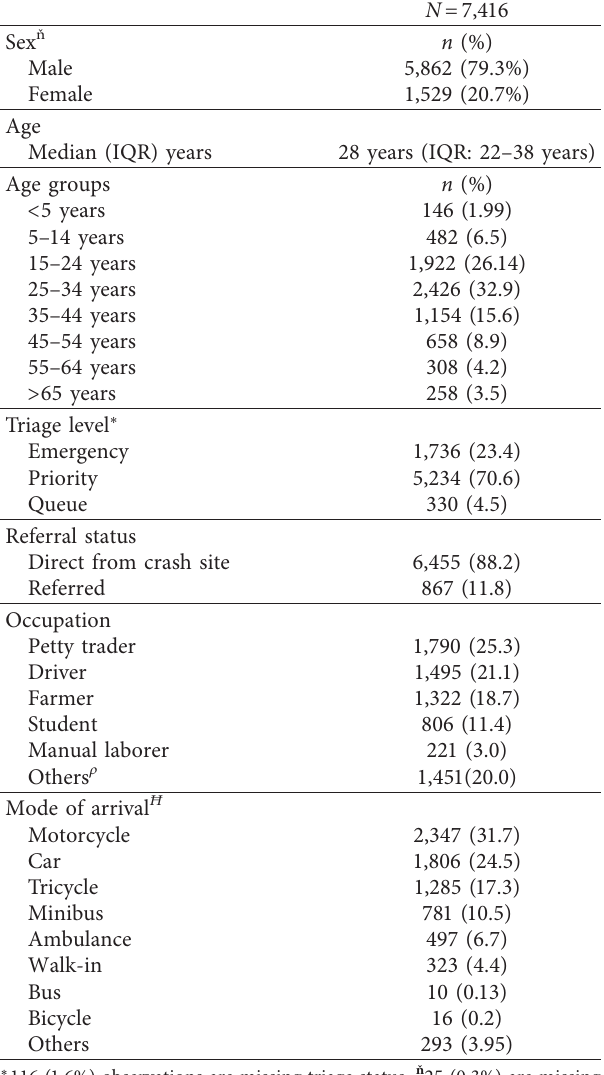
Table 1: RTI patient